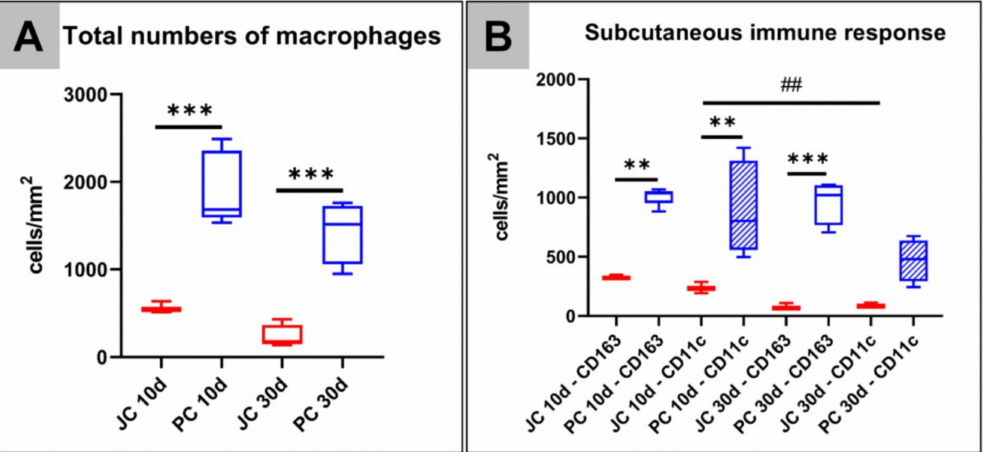
Figure 9. Results of the histomorphometrical analysis of the ( A ) total occurrence of macrophages and ( B ) of the CD163- and CD11c-positive macrophages after implantation of both biomaterials within the subcutaneous connective tissue (* = interindividual significances, # = intraindividual